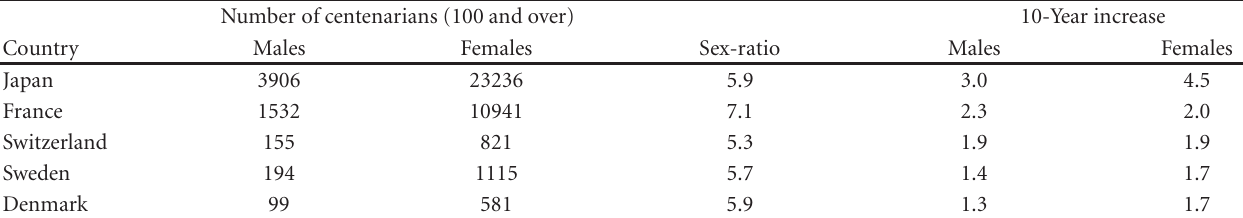
Table 1: Number of centenarians (100+) in 2006 and 10-year increase by sex: Denmark, France, Japan, Sweden, and Switzerland. Number of centenarians (100 and